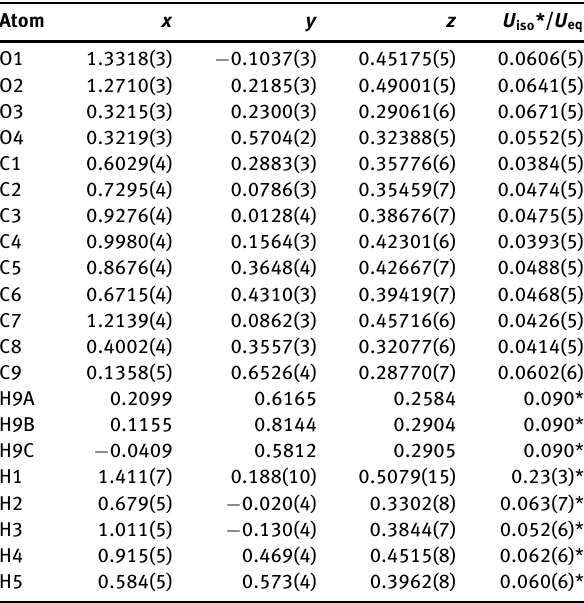
Table 2: Fractional atomic coordinates and isotropic or equivalent isotropic displacement parameters (Å 2